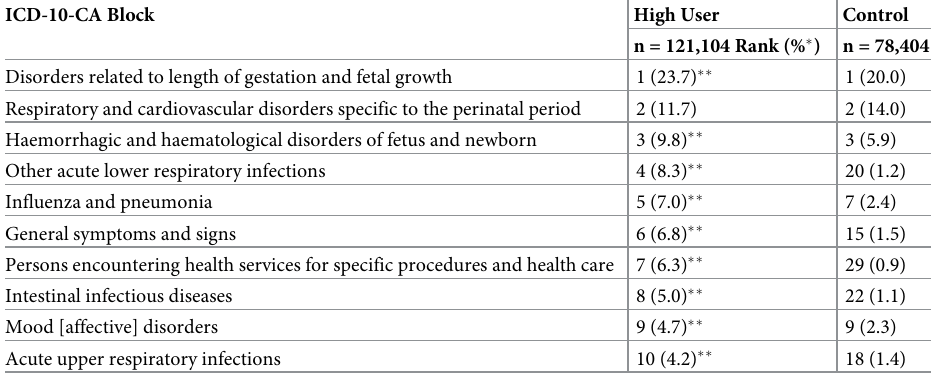
Table 2. Ten most common clinical diagnoses of high hospital users.